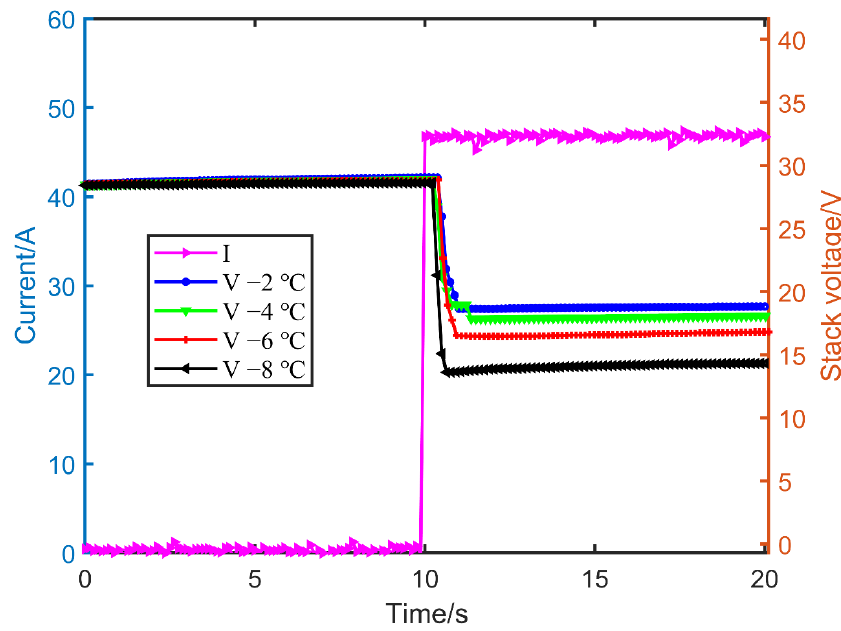
Figure 4. Evolution of stack voltage with different temperatures at 0.15 A/cm 2 .